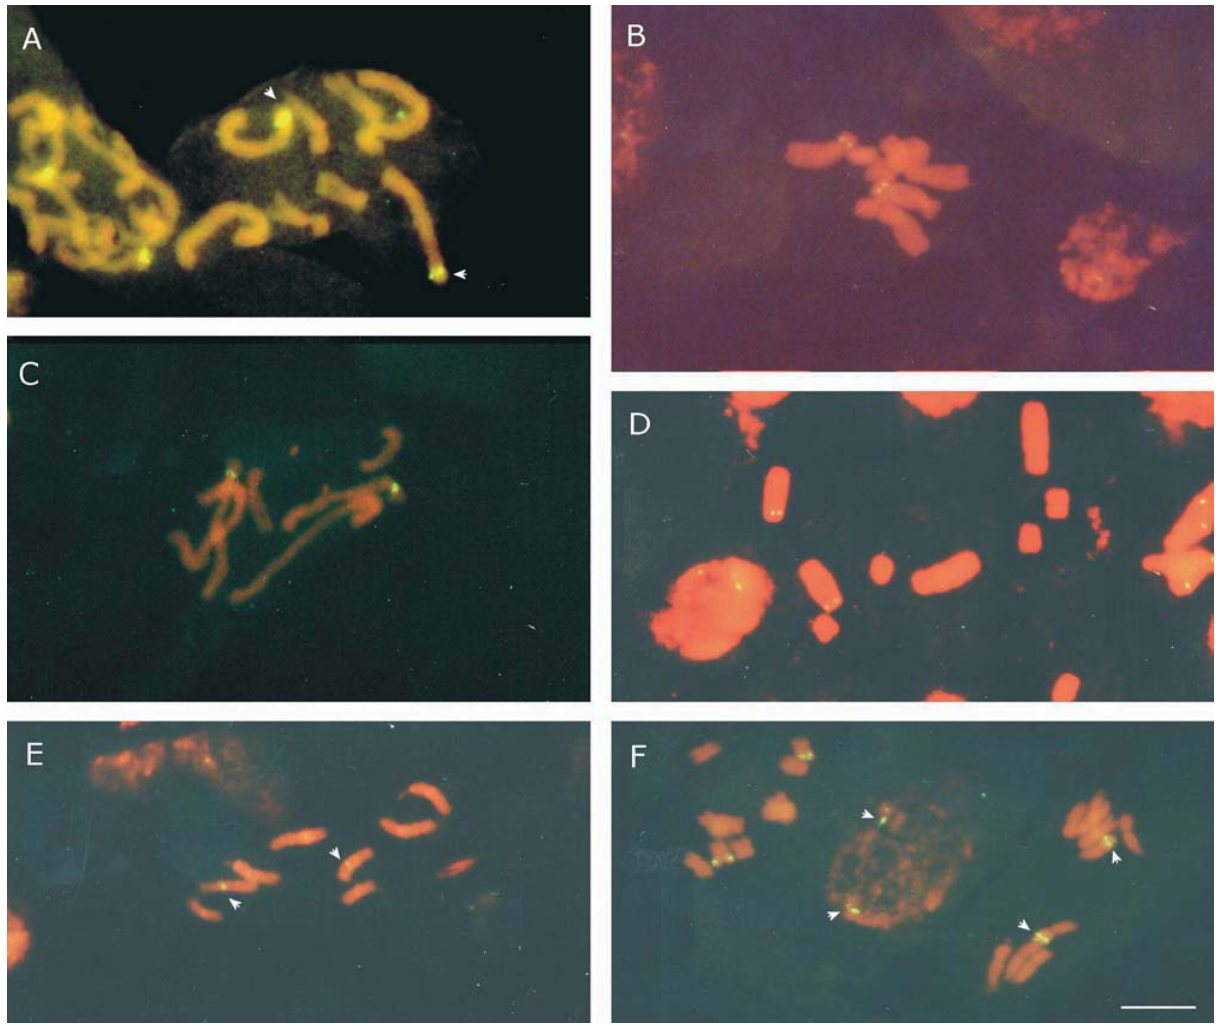
Figure2 -Hybridizationsignalsonmitoticmetaphasesprobedwith5SrDNAgenesin Hypochaeris species:(A) H.grisebashii ,(B) H.microcephala ,(C) H. rosengurtii , (D) H. variegata , (E) H. glabra , and (F) Hypochaeris sp . Bar = 6 µ